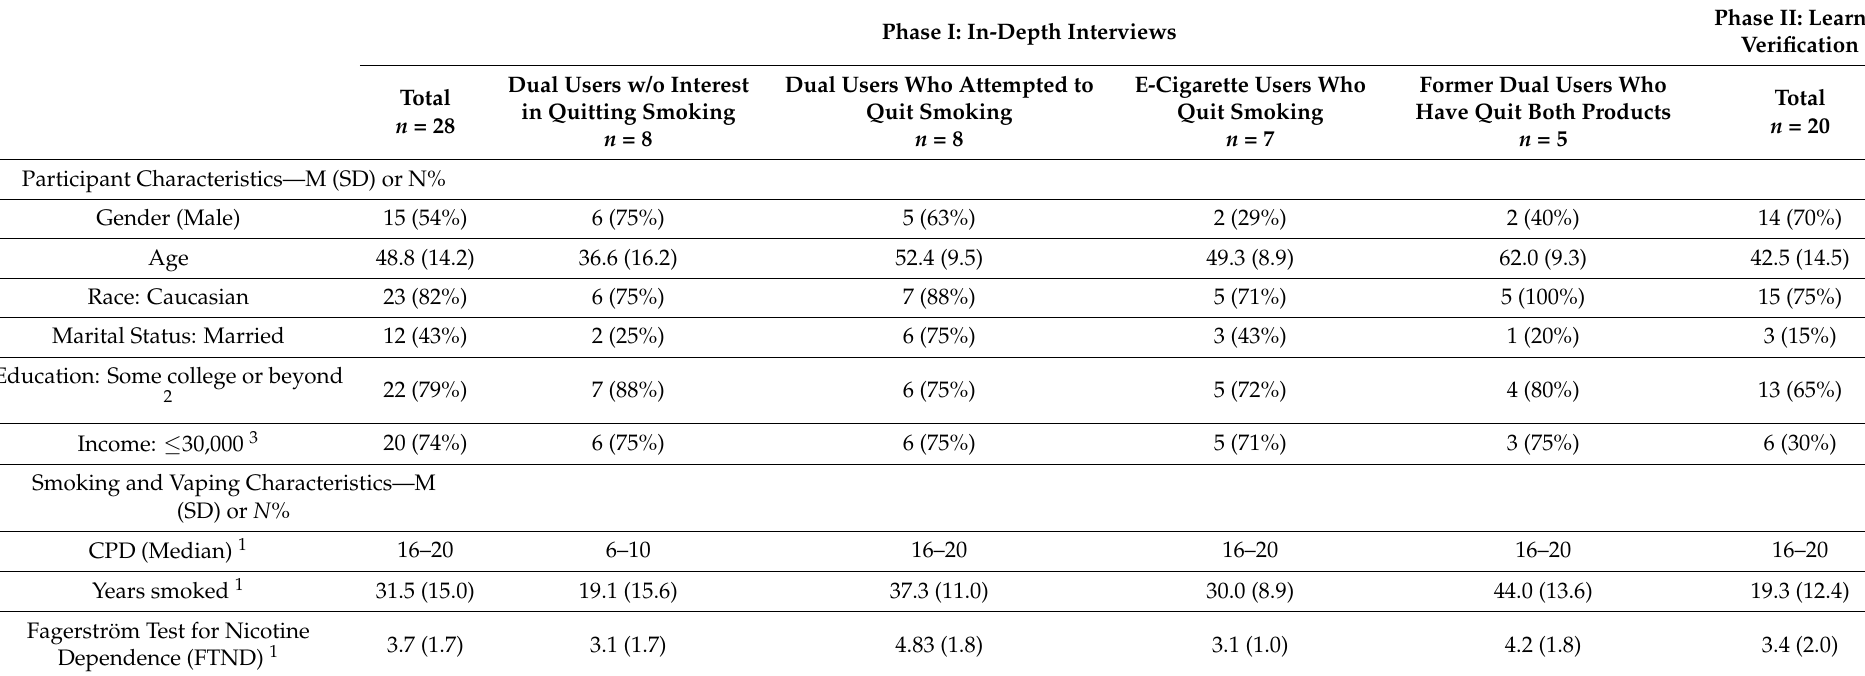
Table 2. In-depth interviews and learner verification: participant demographic and smoking